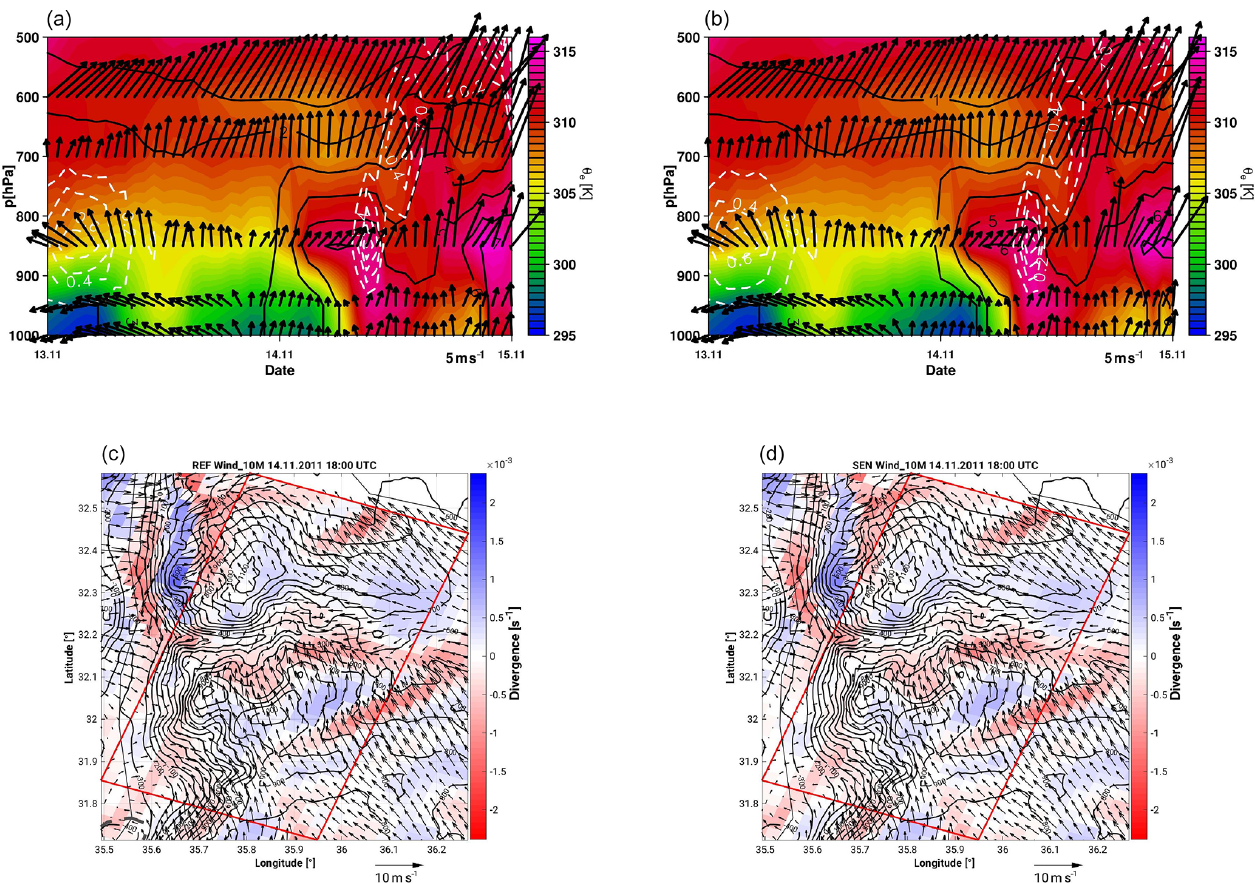
Figure 8. (a, b) Vertical and temporal cross section of equivalent potential temperature (colour scale; K), specific humidity (black isolines; gkg − 1 ), horizontal wind vectors (north pointing upwards; ms − 1 ) and vertical velocity (dashed white contours with 0.1ms − 1 increments) of the REF 14 . 11 (a) and SEN 14 . 11 (b) simulations over a representative grid point in the sub-study region (32.05 ◦ N, 35.79 ◦ E). (c, d) Spatial distribution of 10m horizontal wind (wind vectors; ms − 1 ) and corresponding divergence/convergence field (colour scale; s − 1 ) at 18:00UTC on 14 November 2011 from the REF 14 . 11 (c) and SEN 14 . 11 (d)